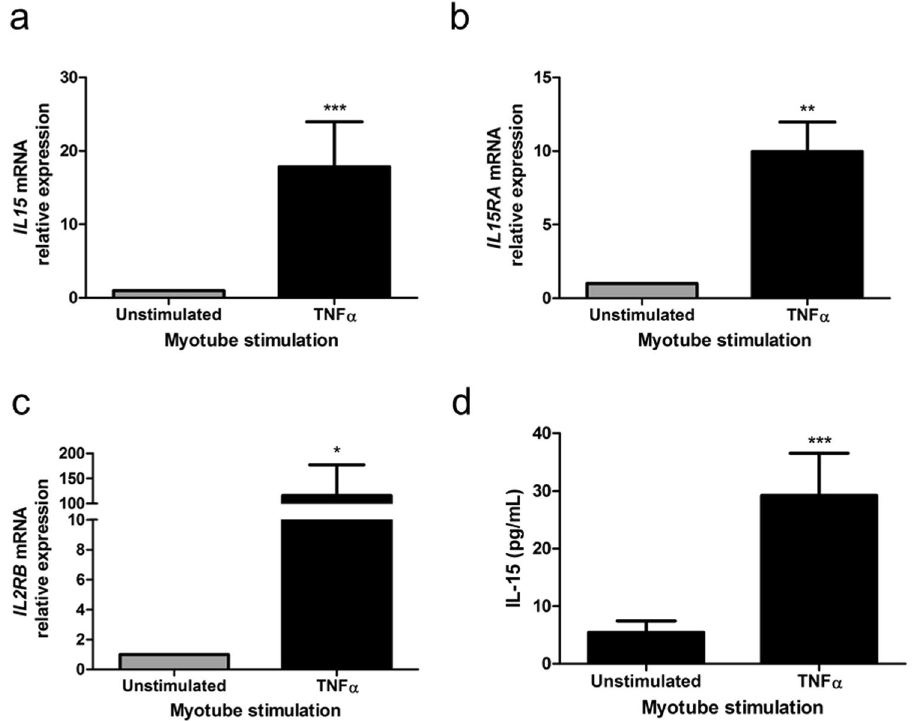
Figure 5. Stimulation of primary human myotubes with recombinant TNF α induces IL-15/L-15 receptor gene expression and the secretion of IL-15. Primary human myotubes were stimulated with recombinant TNF α (20 ng/mL) for 24 hours. ( a , b , c ) IL15 , IL15RA and IL2RB gene expression were quantified by RT-PCR. ** p < 0.01, *** p < 0.001 vs. unstimulated condition by Mann-Whitney U test. 3 technical replicates (each assayed in triplicate) per biological replicate, 3 biological replicates. ( d ) Supernatant IL-15 concentrations were assayed by ELISA. *** p < 0.001 vs. unstimulated condition by one-way ANOVA with post-hoc Bonferroni correction. Data expressed as mean ± SEM; 5 technical replications per biological replicate, 3 biological